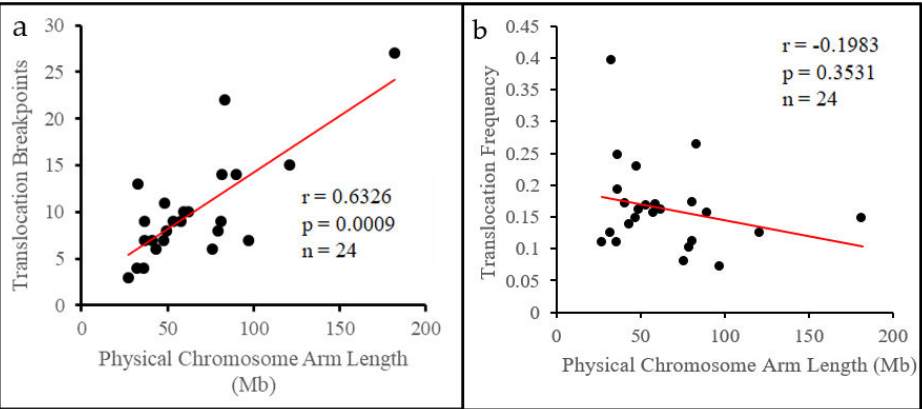
Figure 2. Physical length of chromosome arms is associated with breakpoint number but not the translocation frequency of chromosome arms. ( a ) Scatterplot comparing the number of breakpoints to the physical length of each chromosome arm. Spearman’s correlation coe ffi cient was used to determine if there is a relationship between the two variables. r = Spearman’s correlation coe ffi cient, p = numerical representation that the result was seen by chance, and n = number of chromosome arms included in the analysis. ( b ) Scatterplot comparing the translocation frequency and physical length of each chromosome arm. Spearman’s correlation coe ffi cient was used as described above.